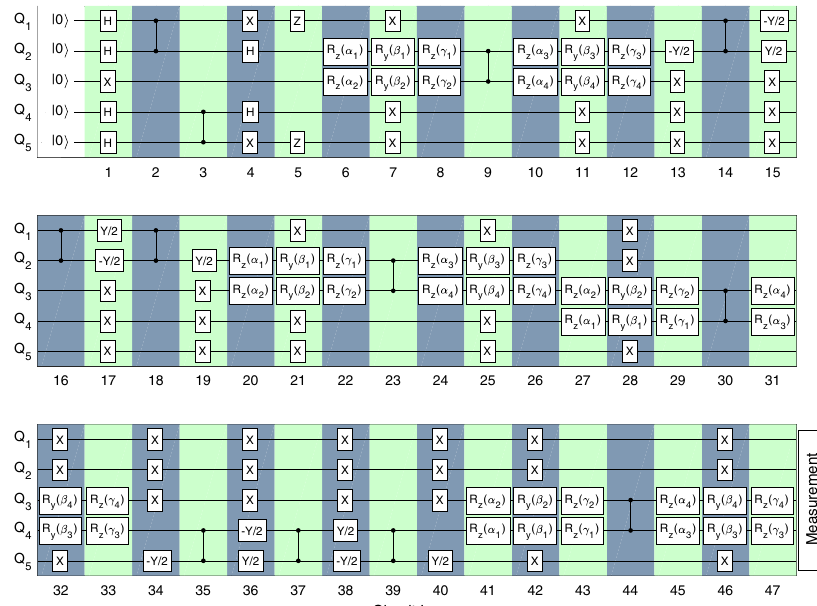
Fig. 6 Gate sequences for the test of random unitaries. The initial state of the target qubit is 1 j i . The total depth is 47, including 12 double- qubit gates and 119 single-qubit